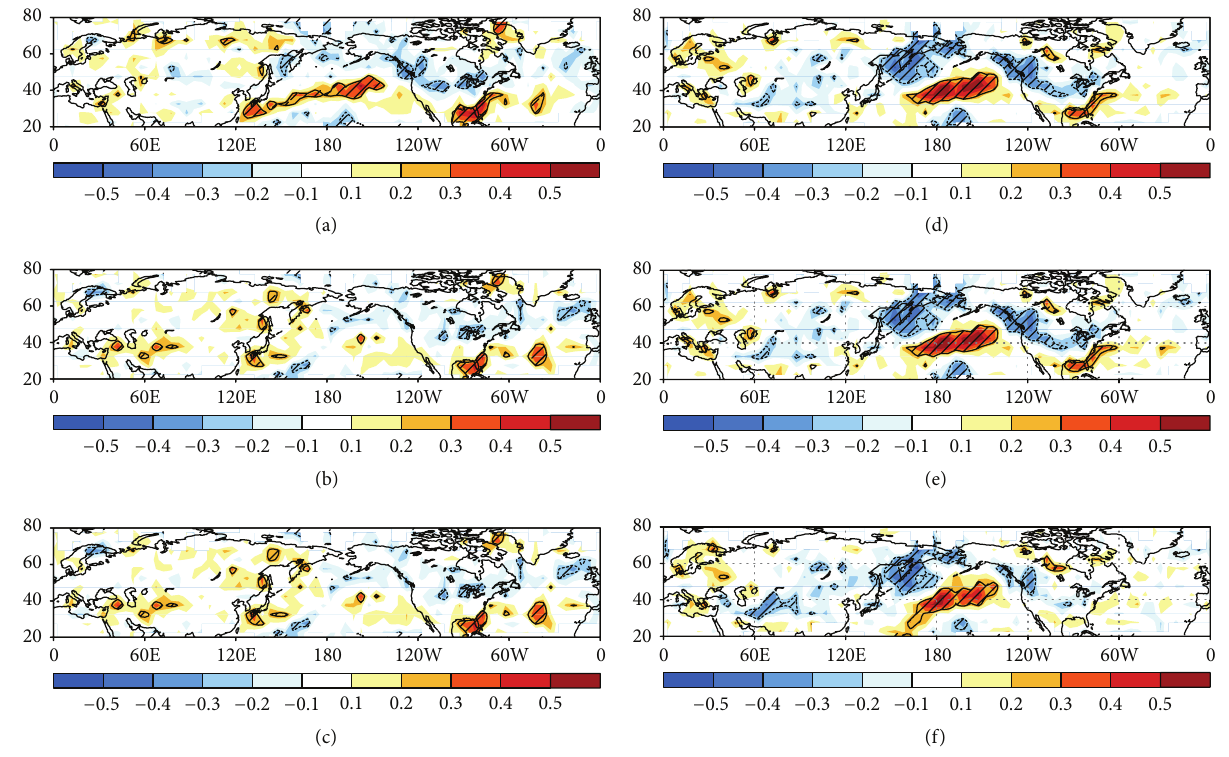
Figure 7: (a)–(c) Correlation coefficient for JFM cyclone frequency versus ENSO for (a) total correlation, (b) excluding PNA, (c) excluding PNA and NAO. (d)–(f) Correlation coefficient for JFM cyclone frequency versus PNA for (d) total correlation, (e) excluding NAO, and (f) excluding NAO and ENSO. Correlation (shaded) 2-tailed 95% significance (hatched).